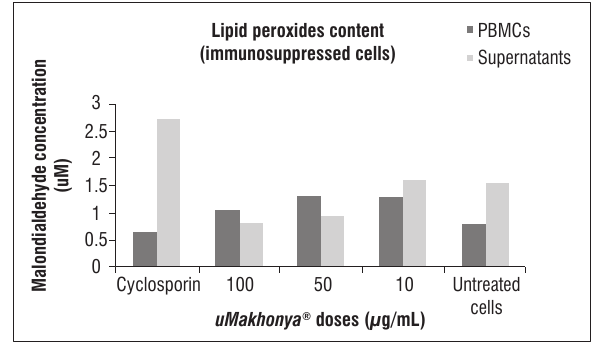
Figure 3: Effects of noncytotoxic doses of uMakhonya ® on levels of lipid peroxides in cyclosporine treated peripheral blood mononuclear cells (PBMCs) and their supernatants.